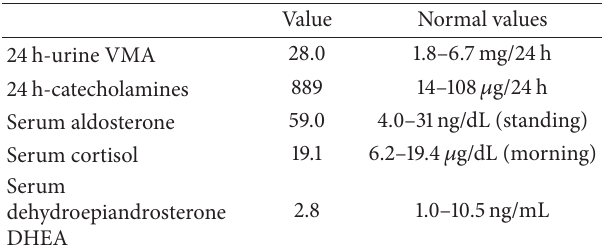
Table 1: Patient’s adrenal hormone